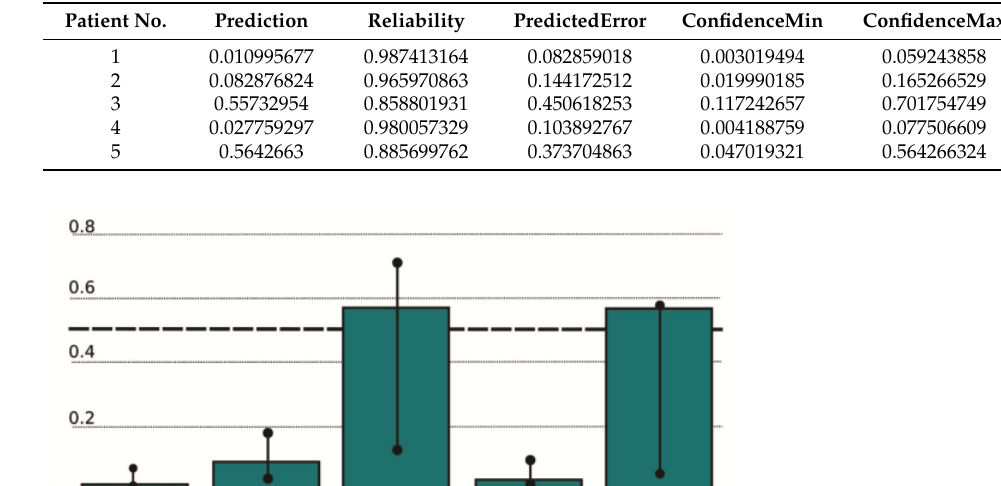
Table 1. Report from the Risk Stratification Tool for the selected five patients. Patient No.